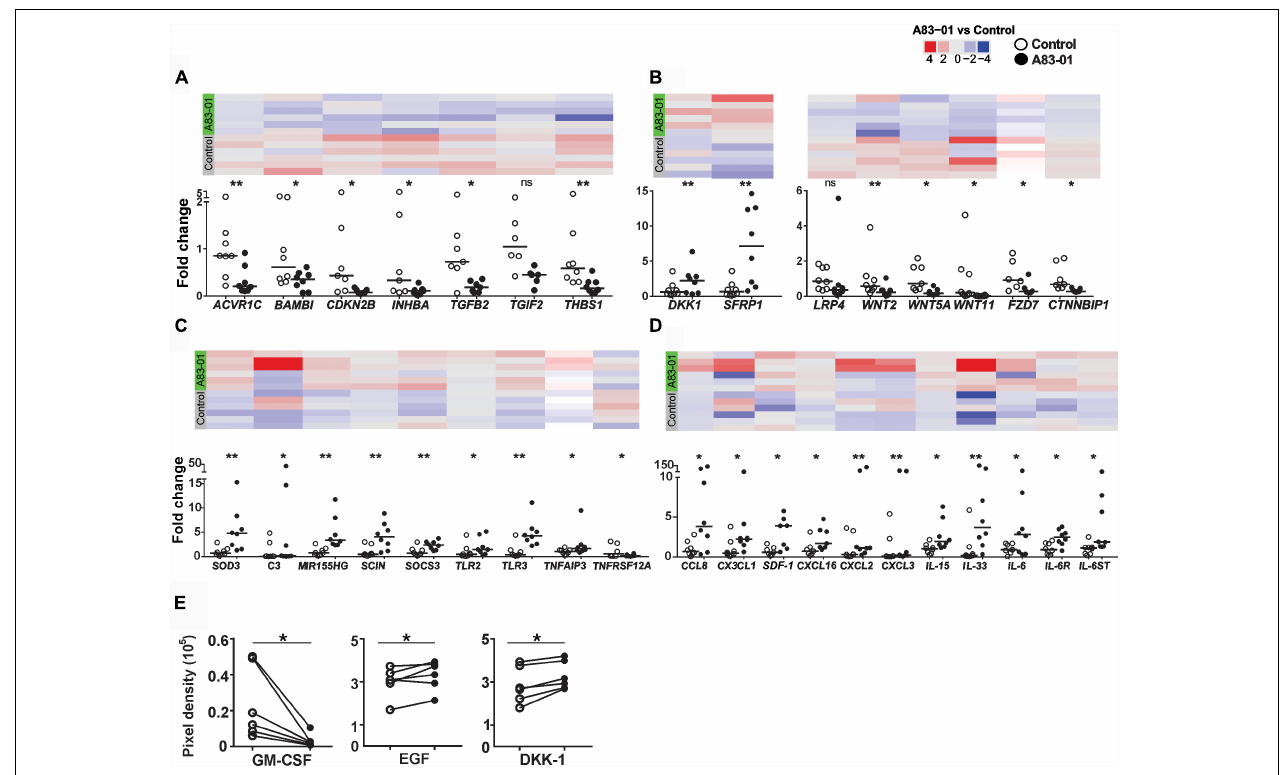
FIGURE 3 | Validation of DEGs in A83-01-treated and untreated-eMSCs in patient samples. (A) TGF- β , (B) Wnt pathways, and (C,D) cytokines and their receptor-related gene expression in A83-01-treated and control P6 eMSCs were validated using Fluidigm qPCR. Black circles, A83-01-treated, white circles, vehicle controls. Individual data points are plotted, bars are medians. Panels above each graph show the heat map of the corresponding genes by RNA seq. (E) Cytokine proteins were determined in the CM of A83-01-treated and control eMSCs using a human XL cytokine array kit. (Graphs are symbols and line to